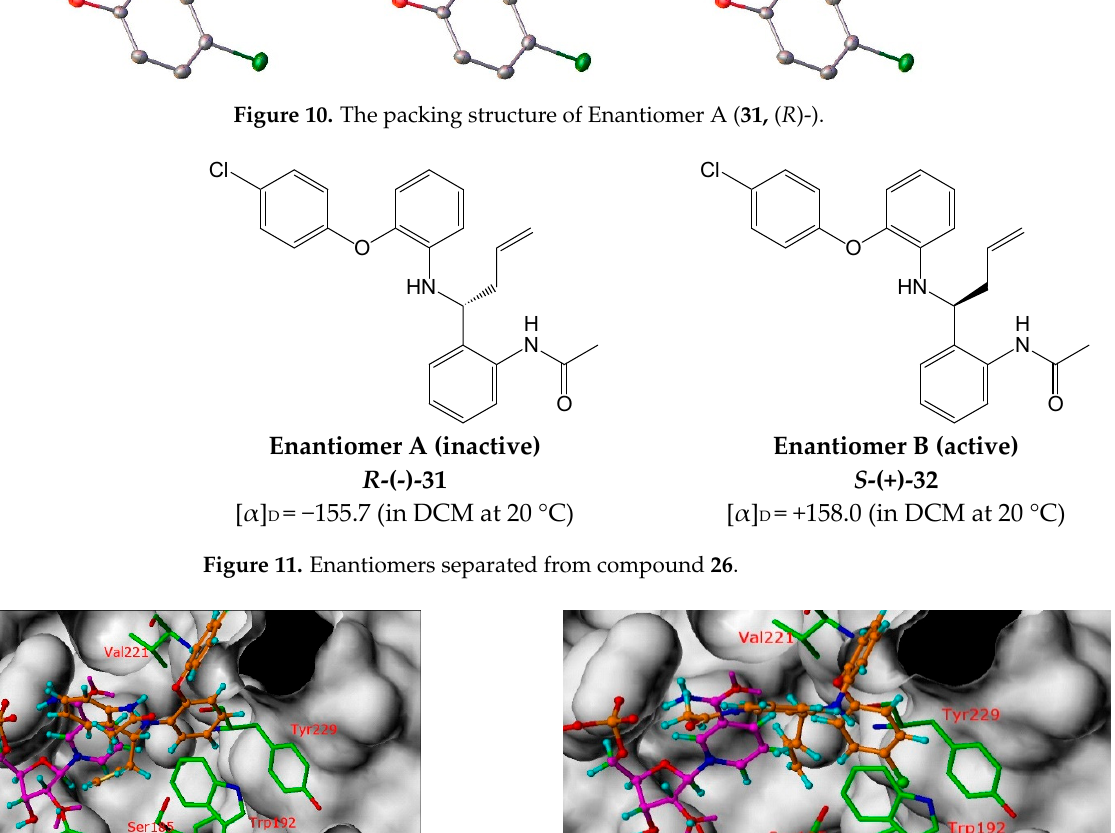
Figure 10. The packing structure of Enantiomer A ( 31, ( R )-).